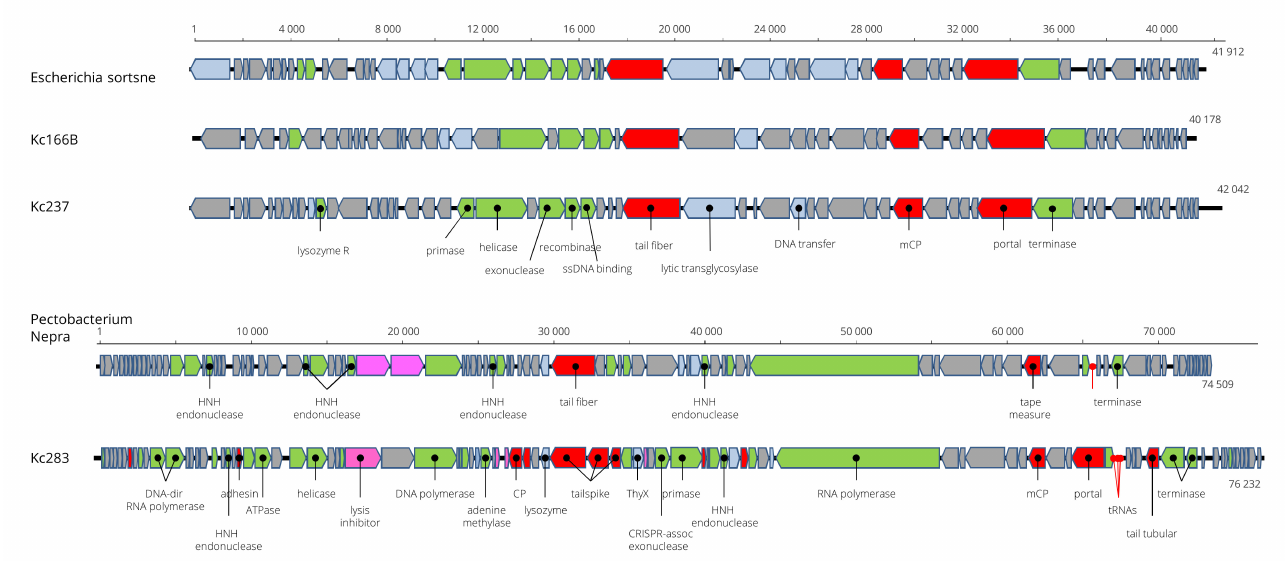
Figure 5. Genome arrangement of Kosakonia viruses Kc166B and Kc237 in comparison to Escherichia phage Sortsne and Pectobacterium phage Nepra.